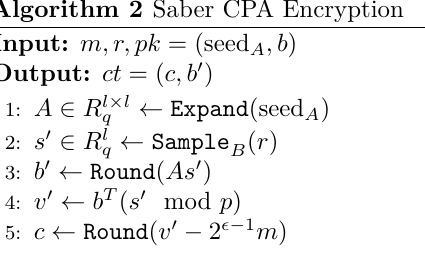
Algorithm 3 Saber CPA Decryption